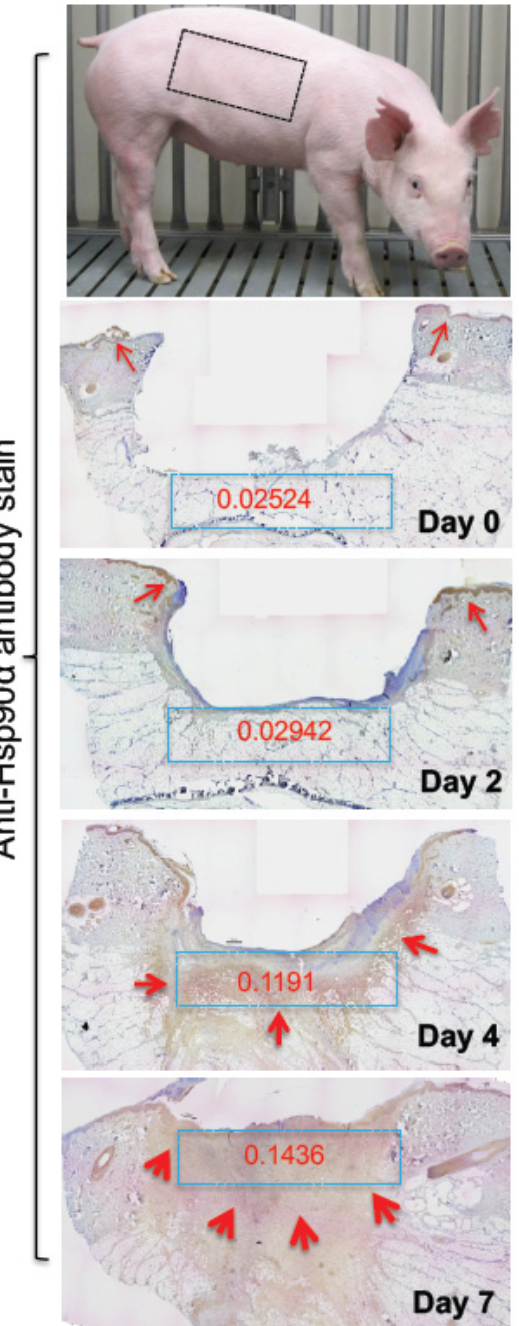
Figure 1. Tissue damage induces massive deposition of eHsp90 α into the wound bed. Pig skin is biologically closest to the human skin. 1.5 cm × 1.5 cm full-thickness excision wounds were created in the indicated area of pig torso. Full wedge (2 cm) biopsies cross the wound were made on the indicated days and immediately frozen on dry ice. Sections of the biopsies were stained with an anti- Hsp90 α antibody. The red arrows point out the locations of the specific antibody staining (brown). Quantitation of the staining in blue boxes was done using Gabriel Landini’s “color deconvolution” and ImageJ analysis. The intensity readings were converted to Optical Density (OD) (The image was taken from reference [55] with